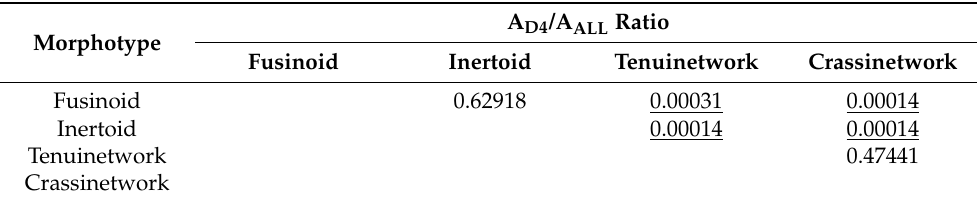
Table 11. Results of the Tukey’s HSD multiple comparison test for the A D1 /A ALL ratio. A D1 /A ALL Ratio Morphotype Fusinoid Inertoid Tenuinetwork Crassinetwork Fusinoid 0.99982 0.00015 0.00014 Inertoid 0.00014 0.00014 Tenuinetwork 0.39791 Crassinetwork